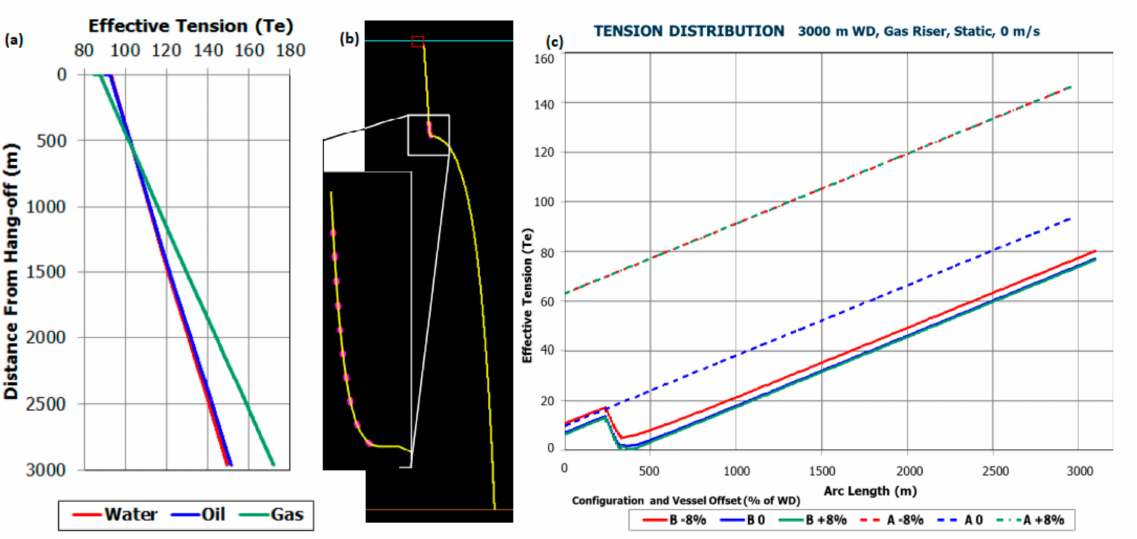
Figure 17. Tension profiles ( a ) during hang-off for different fluids, ( b ) the hang-off configuration when ballasted and ( c ) tension profile when ballasted (Courtesy of 2H Offshore, Source: